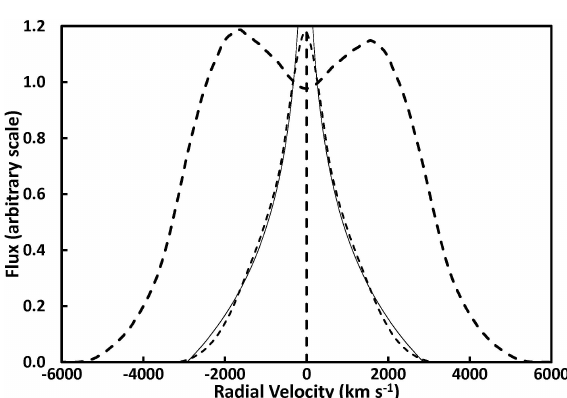
Fig. 2. The dot-dashed line shows the Balmer line profile that would arise from the GKN model if it were centrally illuminated and viewed from 30 ◦ off axis. The profile with short dashes is the same model viewed face-on. The thin line superimposed on this is a logarithmic profile. Figure from Gaskell